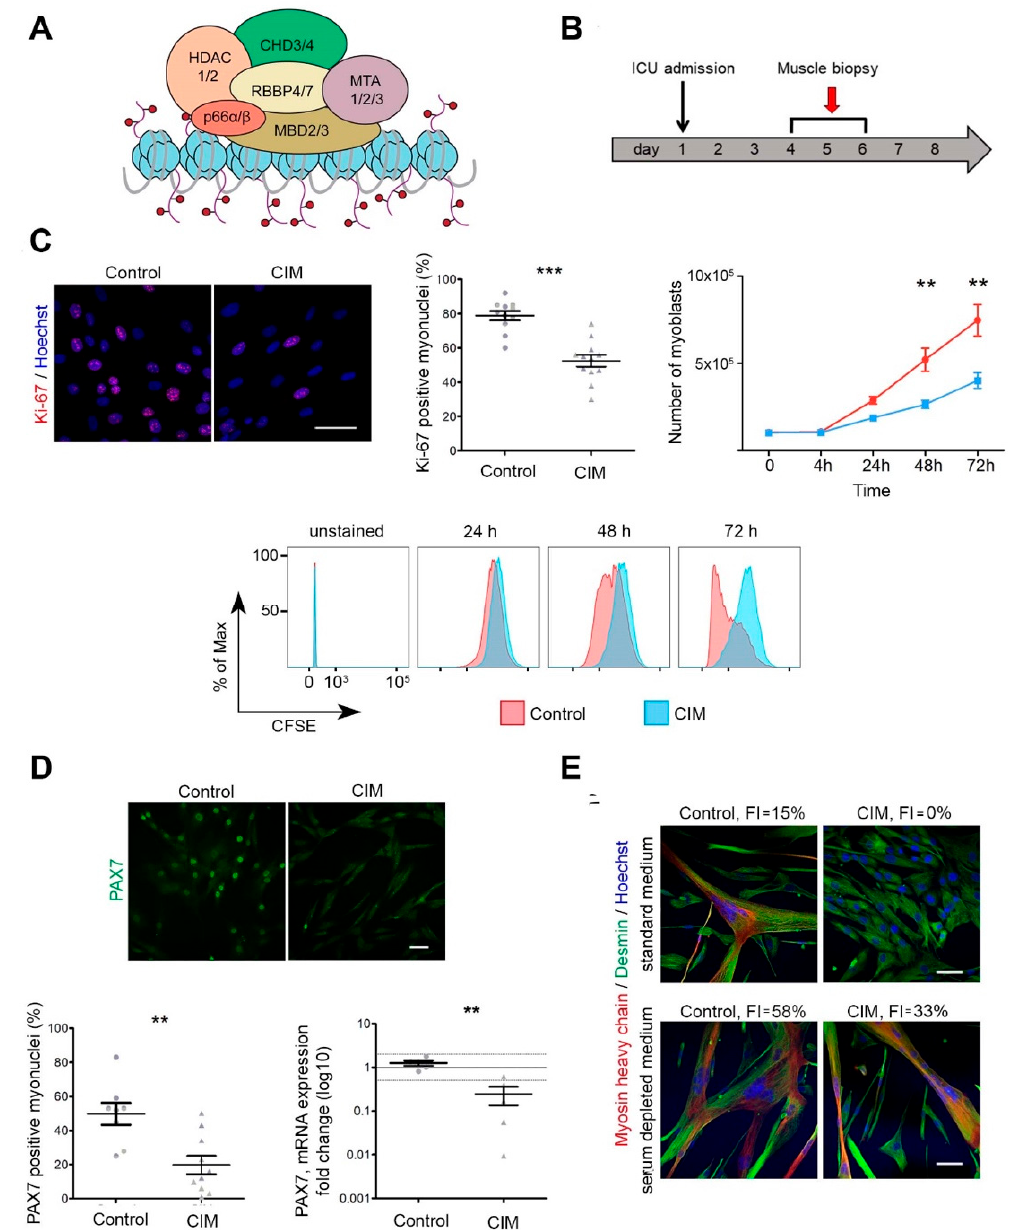
Figure 1. Impaired proliferative and differentiating capacity of CIM-MuSC. ( A ) Schematic overview of NuRD complex composition in muscle tissue. ( B ) Study design. MuSC originated from ICU patients (CIM, n = 12; ICU controls without CIM, n = 3). ( C ) Left: Immunofluorescent staining for Ki-67 (red), Hoechst (blue), and quantification (CIM, n = 12, mean 52%; control n = 11, mean 79%; p = 0.0001). Right and bottom: Carboxyfluorescein succinimidyl ester (CFSE) cell proliferation assay in CIM- (blue) and control MuSC (red) analyzed by FACS at 24 h, 48 h, 72 h; ( n = 4 for CIM- and control MuSC; 24 h: control 2.7 × 10 5 , CIM 2.2 × 10 5 ; 48 h: control 5.2 × 10 5 , CIM 2.6 × 10 5 , p < 0.01; 72 h: control 7.5 × 10 5 , CIM 4.1 × 10 5 , p < 0.01). ( D ) Decreased expression of transcription factor PAX7 in CIM-MuSC. Immunofluorescent staining for PAX7 (green) (CIM, n = 10, mean 20%; control, n = 8, mean 50%; p < 0.01); quantitative PCR of PAX7 (CIM, n = 5; control, n = 5; p < 0.01). ( E ) Reduced fusion capacity of CIM-MuSC after 7 days in standard muscle cell medium ( p < 0.001) or after 5 days in serum-depleted medium ( p < 0.001); n = 4 for CIM- and control MuSC. Immunofluorescent staining for desmin (green), myosin heavy chain (red), and Hoechst (blue). FI—Fusion index. ** p < 0.01. *** p < 0.001.